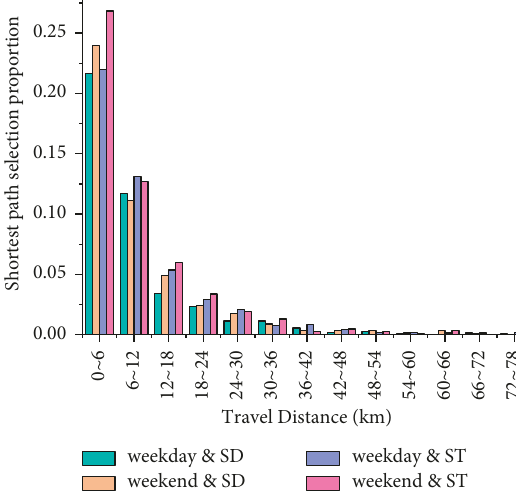
Figure 14: A global selection of different distance intervals for the shortest